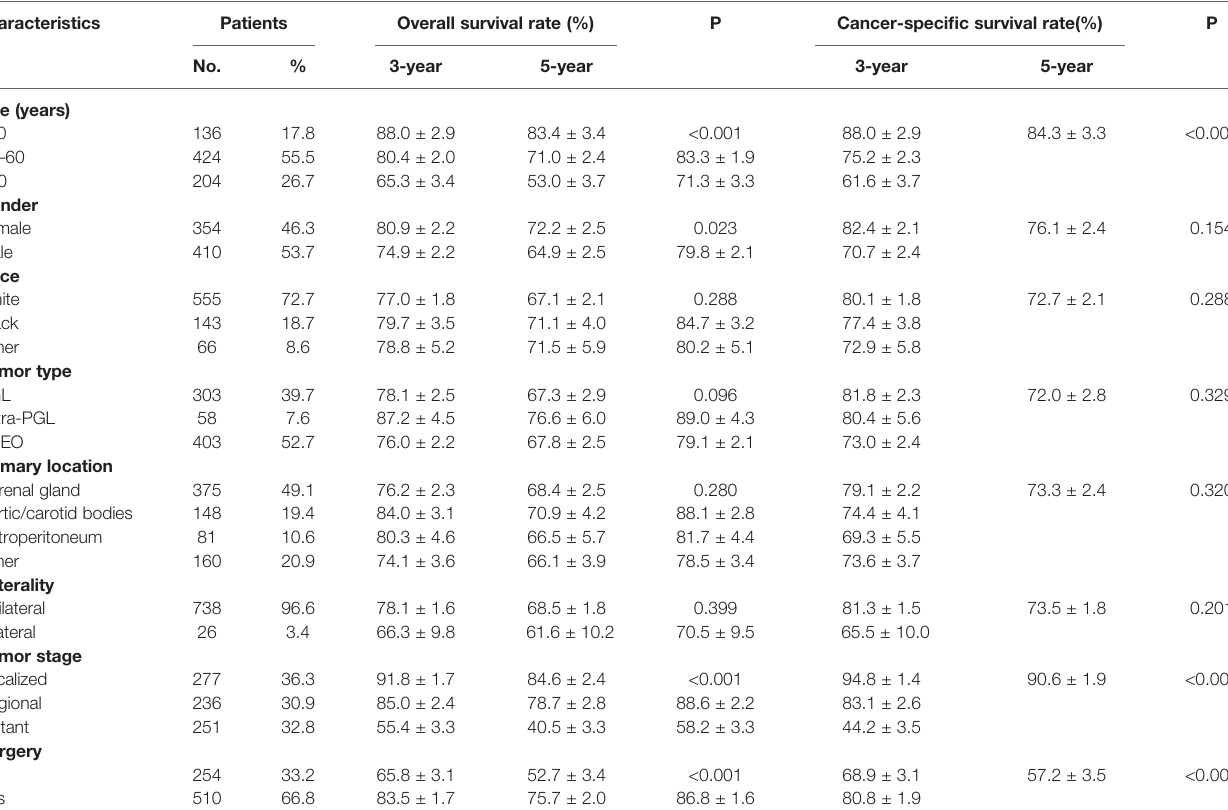
TABLE 1 | Patient characteristics and 3- and 5-year OS and CSS rates.